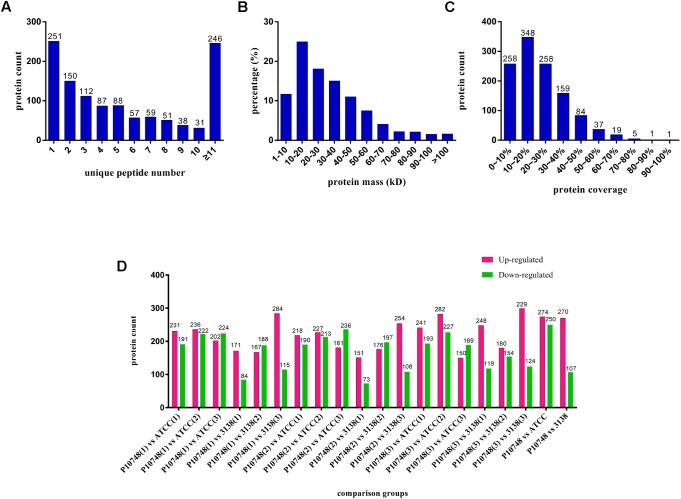
Profiles of membrane proteins identified in three Enterococcus faecalis isolates. (A) Number of unique peptides identified for individual proteins. X axis represents the number of unique peptide. Y axis represents the number of proteins. (B) Distribution of molecular mass among all identified proteins. X axis represents molecular mass (kDa). Y axis represents the percentage of the number of proteins. (C) Coverage of identified proteins. X axis represents coverage, which refers to the proportion of the amino acid sequence of each protein covered by peptides. Y axis represents the number of proteins. (D) Differentially expressed proteins of each compared group. X axis represents each compared group. Y axis represents the number of proteins. Up-regulated proteins are indicated in red and down-regulated proteins are indicated in green. Each isolate was tested in triplicate (indicated as 1, 2, and 3 in parentheses) and compared to other isolate separately.